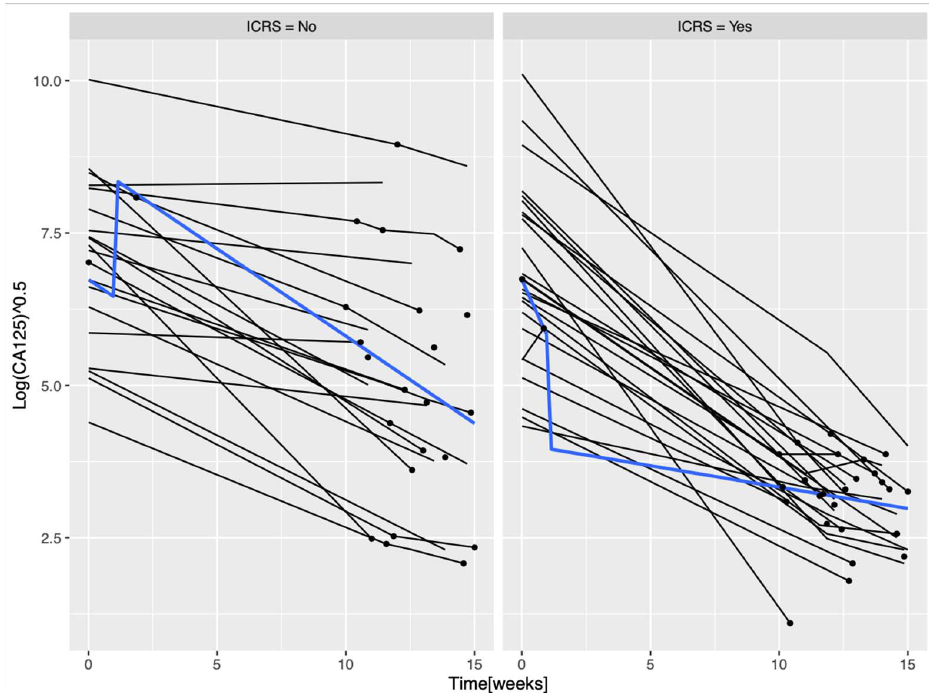
Figure 2. Plot longitudinal CA-125 levels. Individual evolution in time of the CA-125 values, sepa- rately for resectable (IRCS = yes) and non-resectable (ICRS = no) patients. The blue line represents the median value of CA-125. Abbreviations: ICRS: interval cytoreductive surgery.